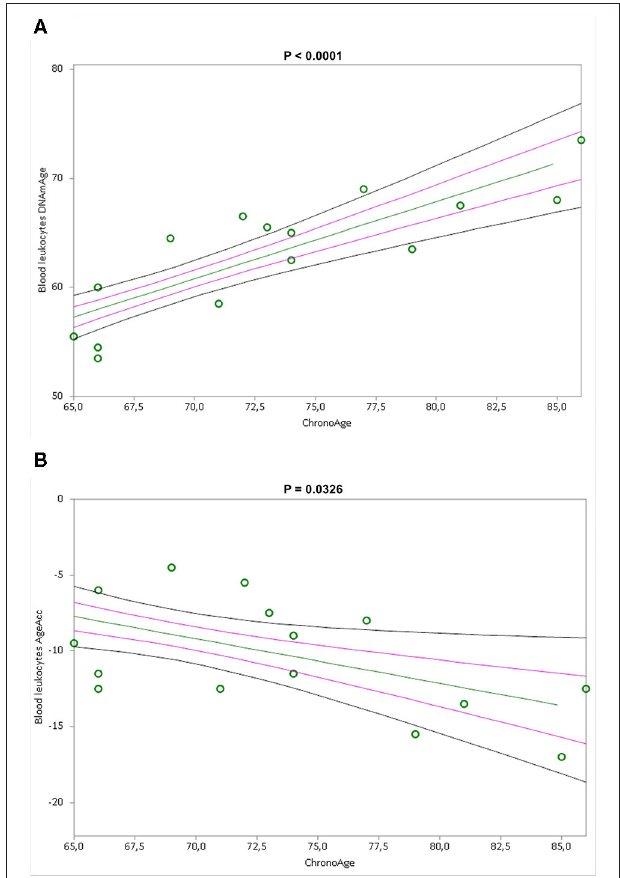
FIGURE 4 | Correlation curves between blood leukocytes and induced sputum cells DNAmAge (A) or AgeAcc (B) of n = 7 COPD patients. In (A) , a simple linear regression plot shows the correlation between blood leukocytes and induced sputum cell DNAmAge [correlation coefficient (r) = 0.927245; two-sided p = 0.0026], whereas in (B) , a simple linear regression plot shows the correlation between blood leukocytes and induced sputum cells AgeAcc [correlation coefficient (r) = 0.916445; two-sided p = 0.0037]. Mean, standard error (SE), and 95% coefficient intervals (CI) are represented as green, pink, and black lines,